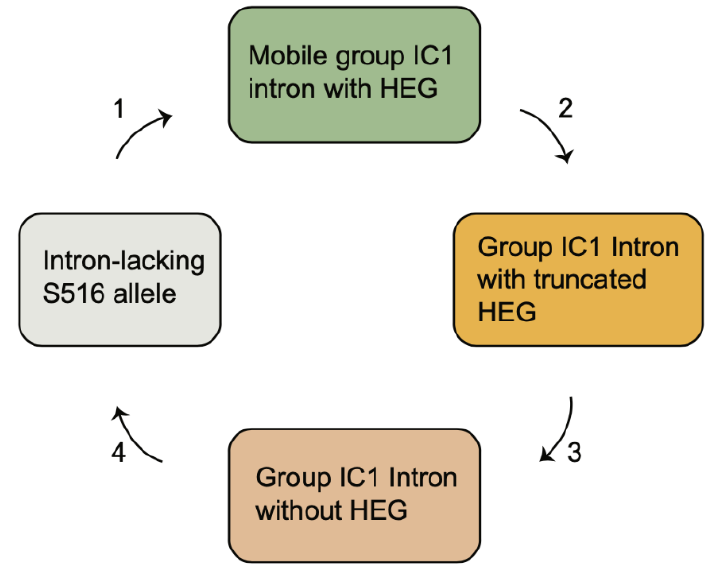
Figure 6. The evolutionary history of nucleolar S516 group I introns based on invasion and extinc- tion.